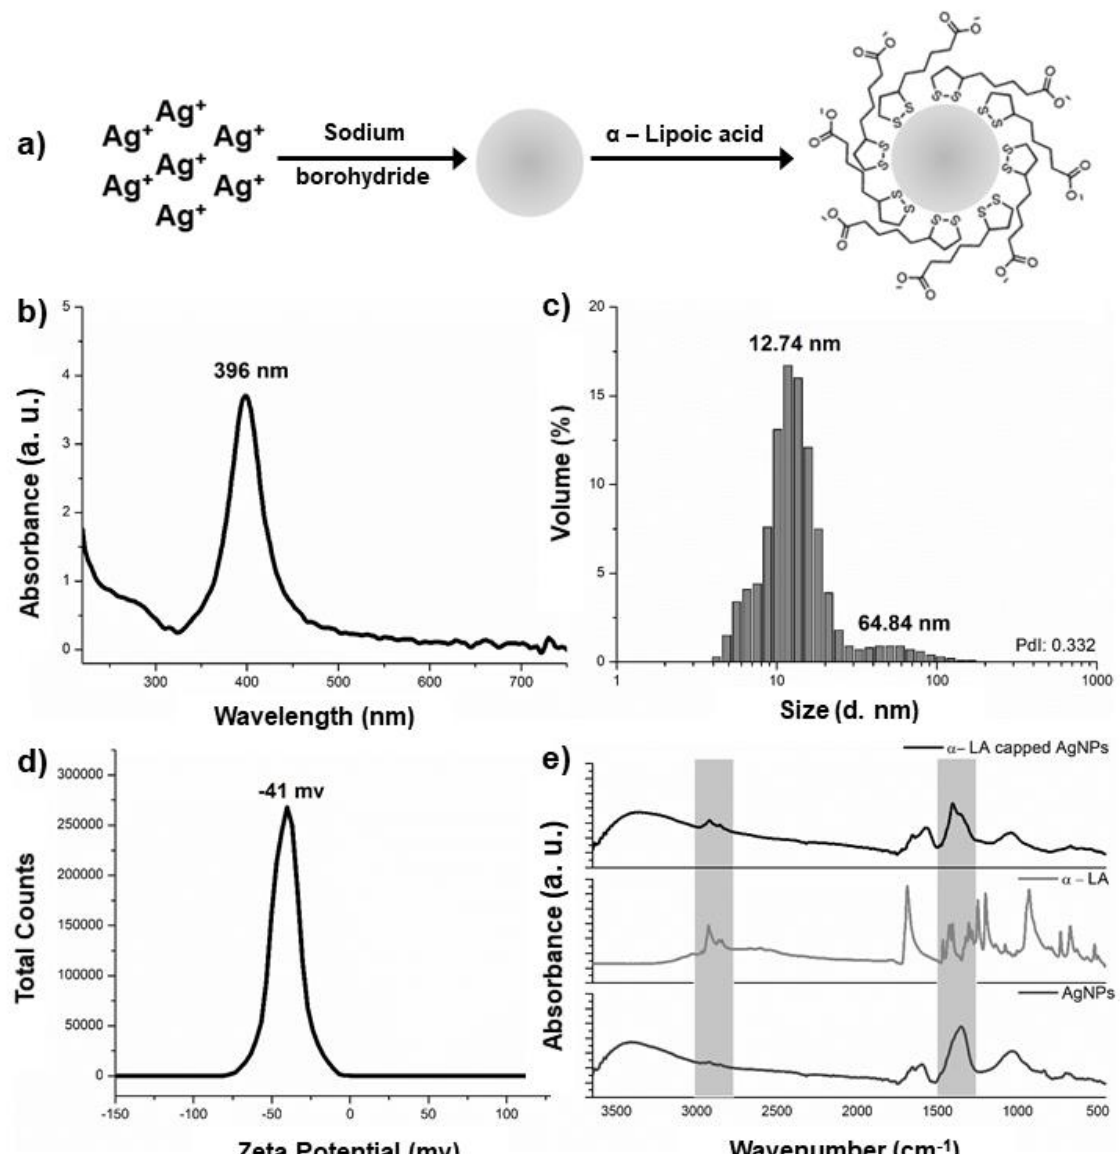
Figure 1. Synthesis and characterization of α -LA capped AgNPs. ( a ) Scheme of synthesis and functionalization of AgNPs; ( b ) UV-Vis absorption spectra of α -LA capped AgNPs; ( c ) Hydrodynamic size measured by DLS of α -LA capped AgNPs; ( d ) Zeta potential of α -LA capped AgNps; ( e ) FT-IR spectra of bare nanoparticles, α -LA, and α -LA capped AgNPs.